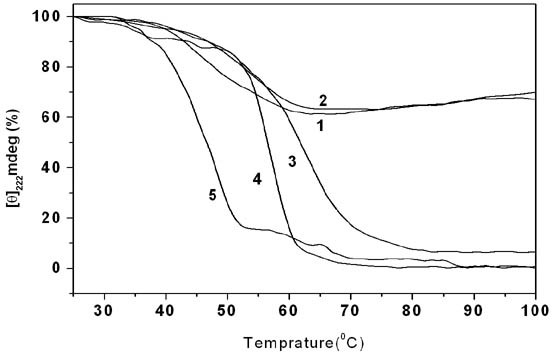
Thermal unfolding of salt-treated MtαIPMS. Effect of increasing temperature on the CD ellipticity at 222 nm of MtαIPMS (profile 1), MtαIMPS in presence of 5 mM KCl (profile 2), 5 mM MgCl2 (profile 3), 0.25 mM ZnCl2 (profile 4) and 0.25 mM CdCl2 (profile 5), respectively. The values have been represented as percentage with the value obtained at 25°C for each sample taken as 100 percent, respectively.